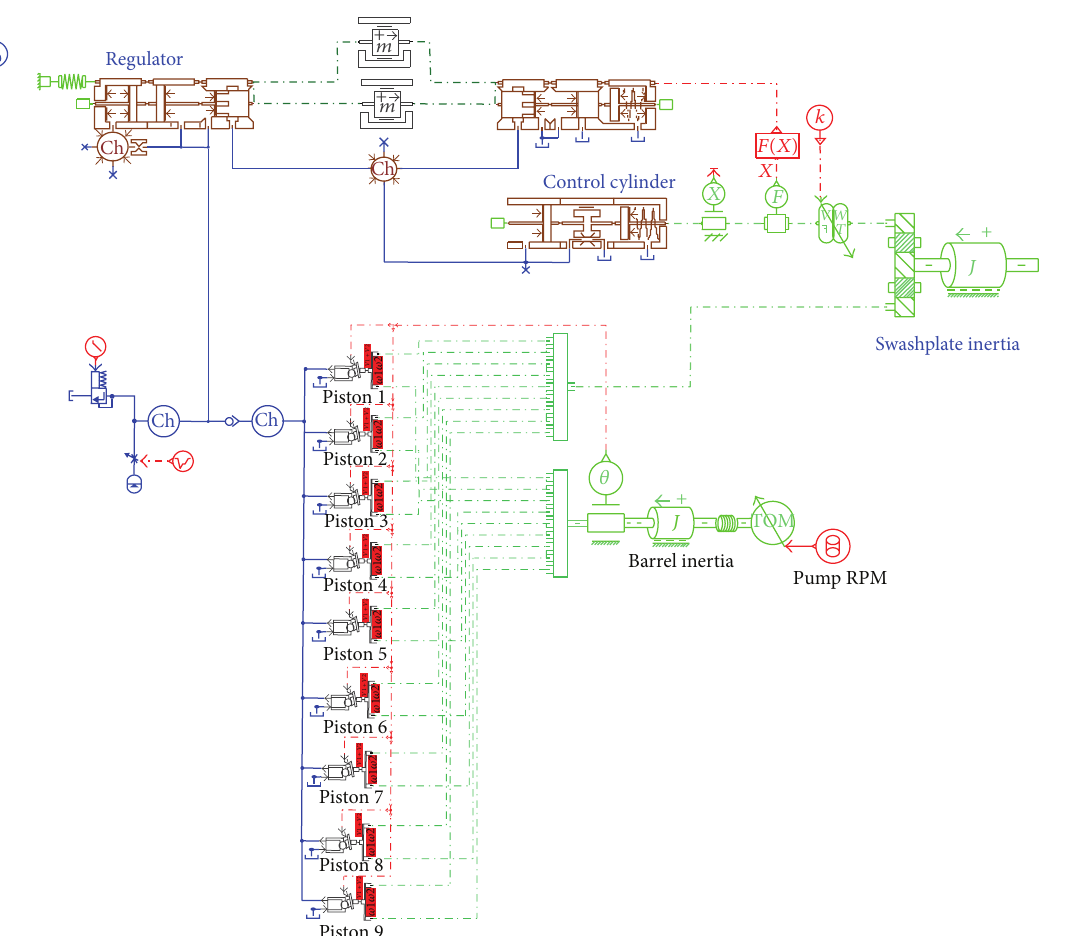
Figure 16: Simulation diagram of constant power regulator system based on AMESim software.